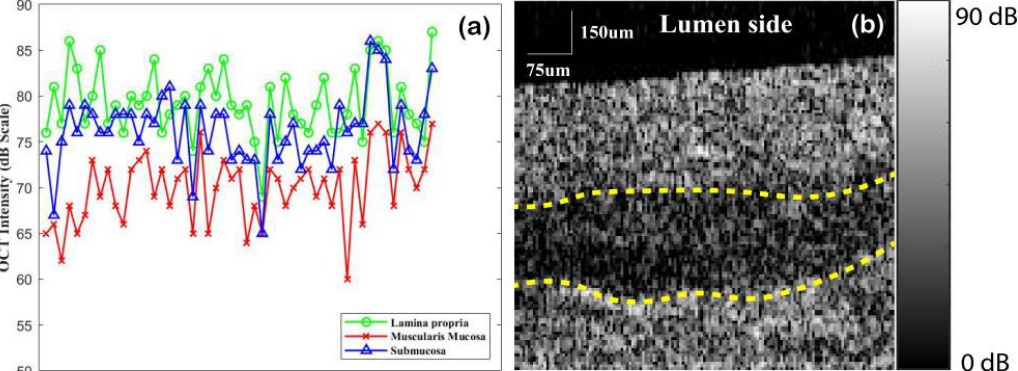
Figure 4. ( a ) OCT intensity values of different oesophageal tissue layer for each of the 52 samples. The OCT intensity is in dB scale. ( b ) OCT structure image, which the yellow dashed lines indicate the boundary between layers, from lumen side, top to bottom, the layers are Lamina propria, Muscularis Mucosa, and Submucosa